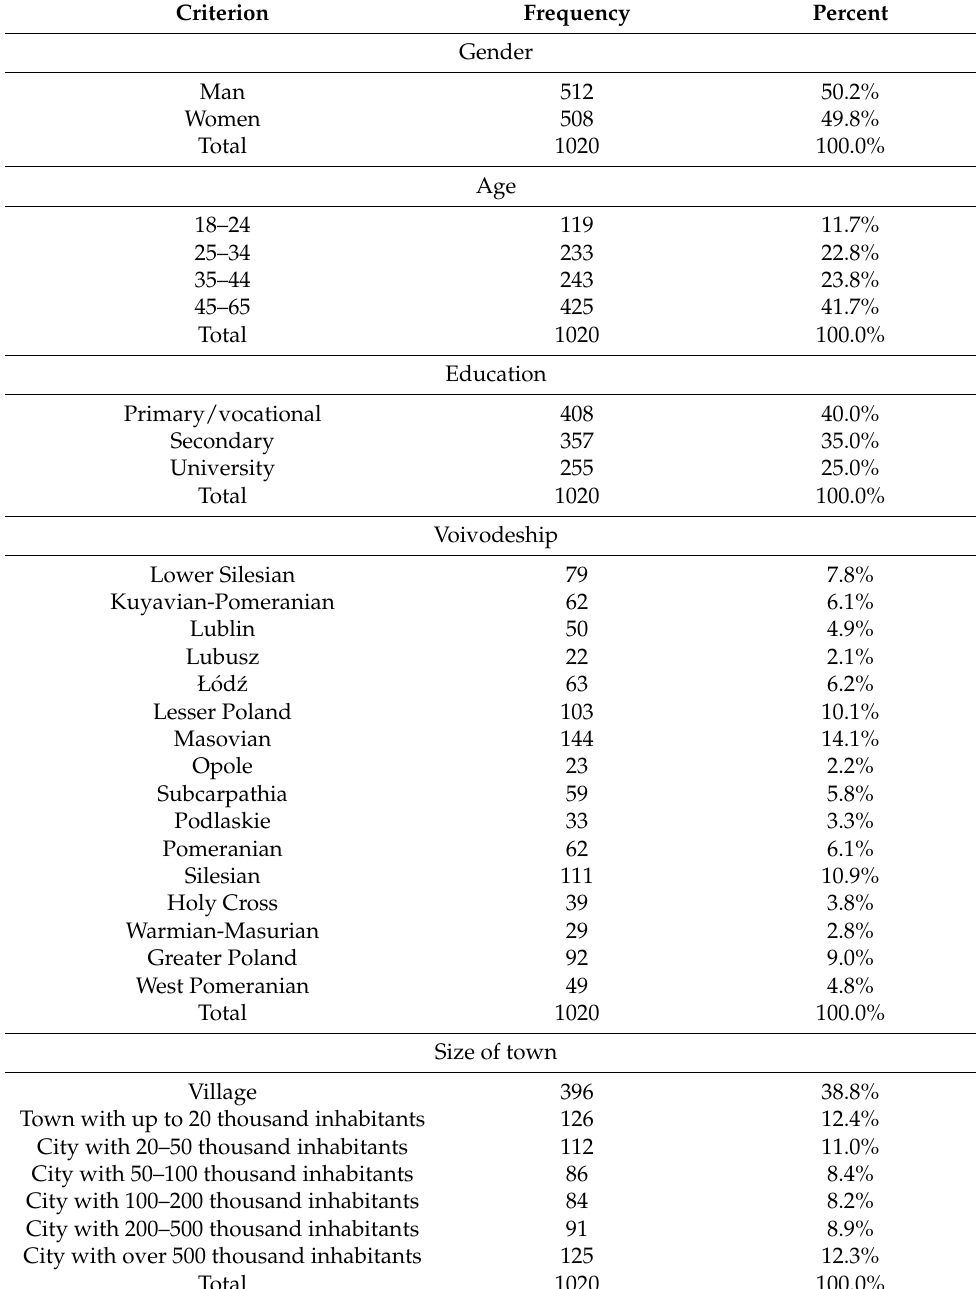
Table 1. Characteristics of the research